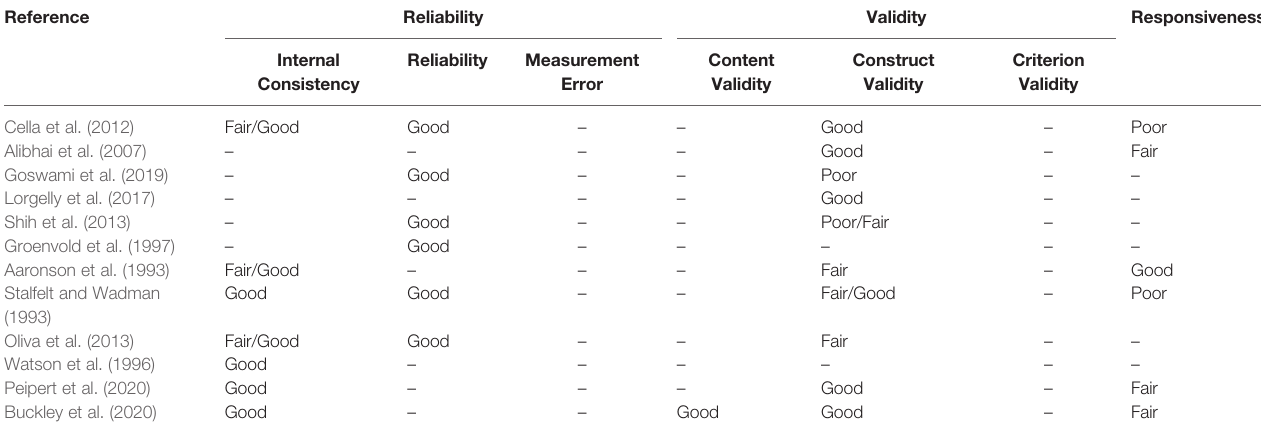
TABLE 4 | COSMIN Checklist Scores evaluating the methodological quality of each